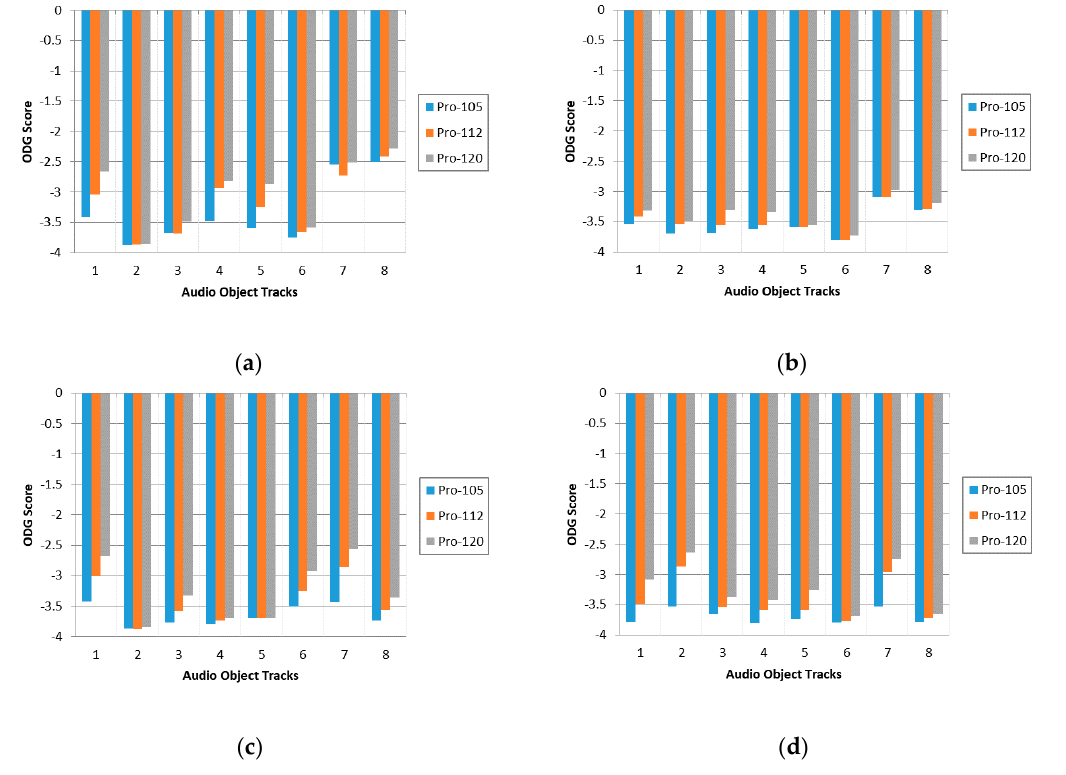
Figure 5. The ODG score of four multi-track audio files, where each file correspond to three types of bitrates. ( a – d ) represent the results for 4 multi-track audio files.